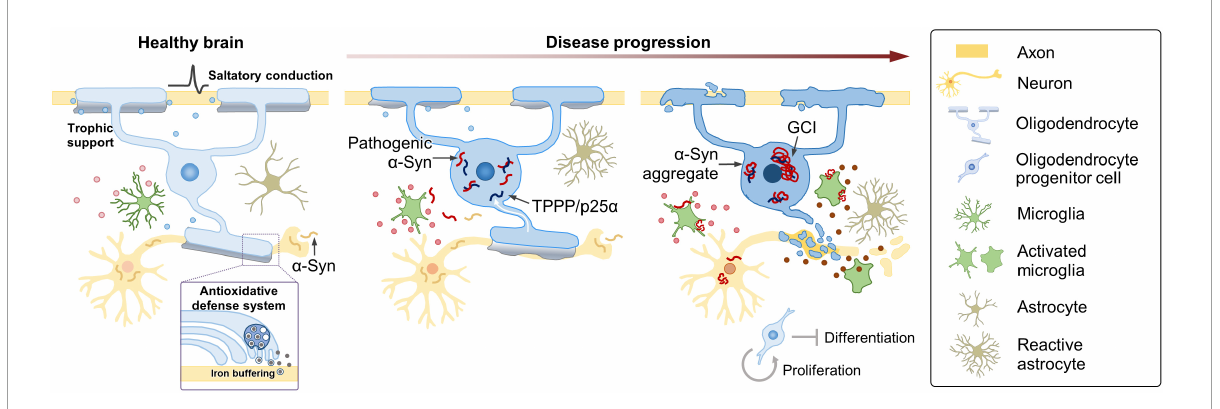
FIGURE1 Oligodendroglial pathology and possible mechanisms contributing to MSA. Under healthy conditions, OLs enable saltatory conduction of electrical signals, provide metabolic and trophic support, and play a role in providing an antioxidant defense system to neurons. In MSA, TPPP/p25 α relocates from the myelin sheath to the cell body, prior to α -Syn aggregation. Redistribution of TPPP/p25 α causes cellular enlargement, and α -Syn starts to accumulate in the enlarged cytoplasm. Metabolic and trophic support of OLs to neurons is compromised, iron overload increases, and oxidative stress becomes aggravated. At later stages, α -Syn aggregates form GCIs in OLs. α -Syn is transformed into a toxic form in the intracellular environment of OL, where α -Syn seems to acquire distinct characteristics of MSA. MSA-type α -Syn might be transferred to neurons, and pathogenic α -Syn may induce neurodegeneration by directly interfering with essential neuronal functions or indirectly via aberrant activation of micro- and astrogliosis. As the disease progresses, microglia become destructive by releasing neurotoxic inflammatory mediators, such as cytokines, chemokines, and reactive oxygen and nitrogen species. The changing state of microglia, reflected in part, by their secretory profile, might play a crucial role in the progression of MSA. Enhanced proliferation of OPCs occurs, perhaps in an attempt to compensate for the myelin loss, but under the burden of α -Syn, immature oligodendroglia fail to differentiate and undergo cell